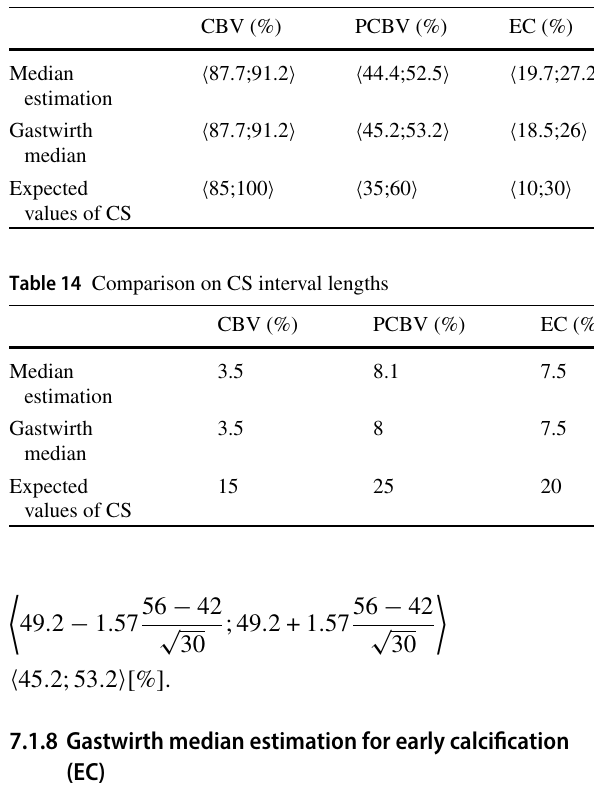
Table 13 Comparison of CS interval estimation